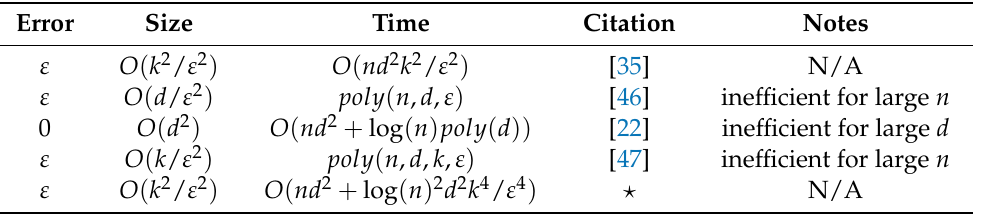
Table 1. Known deterministic subset coresets for LMS solvers. Our result has the fastest running time for sufficiently large n and d